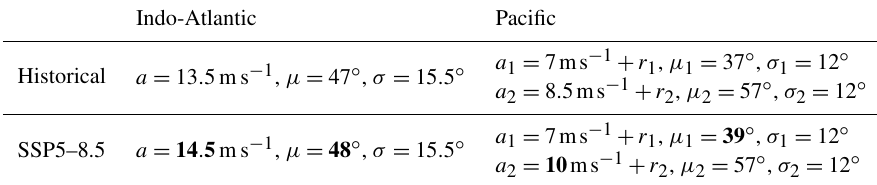
Figure 5. Zonal-mean zonal wind in the Pacific sector (120–300 ◦ ); individual CMIP6 models in grey and their average in black. In light red are the individual realisations of the toy model (see Sect. 3.3) and in dark red their average. (a) Historical period, (b) the SSP5–8.5 scenario, and (c) the climate-change response as the difference between panel (b) and panel (a) . Table 1. Toy model parameters from Eq. (1) used to fit the Indo-Atlantic jet (see Fig. B1) and the double-jet structure in the Pacific (see Fig. 5) for both the historical and SSP5–8.5 scenarios. The strengths of the Pacific double-jet structure a 1 and a 2 are the base values, to which a random perturbation is added in each model realisation. The subscripts 1 and 2 refer to the more equatorward and more poleward Pacific jet, respectively. The parameter values that change to approximate the SSP5–8.5 response are highlighted in